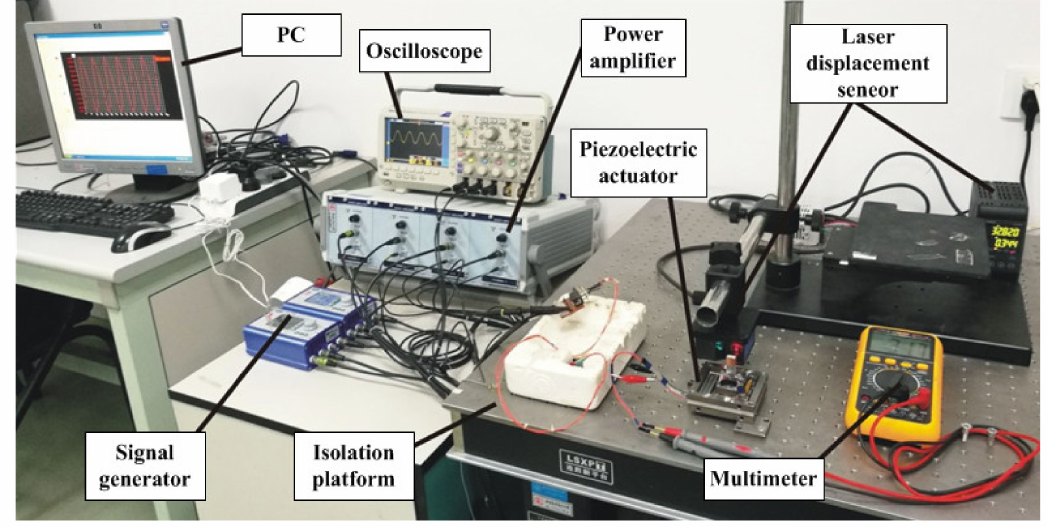
Figure 16. The experiment environment.